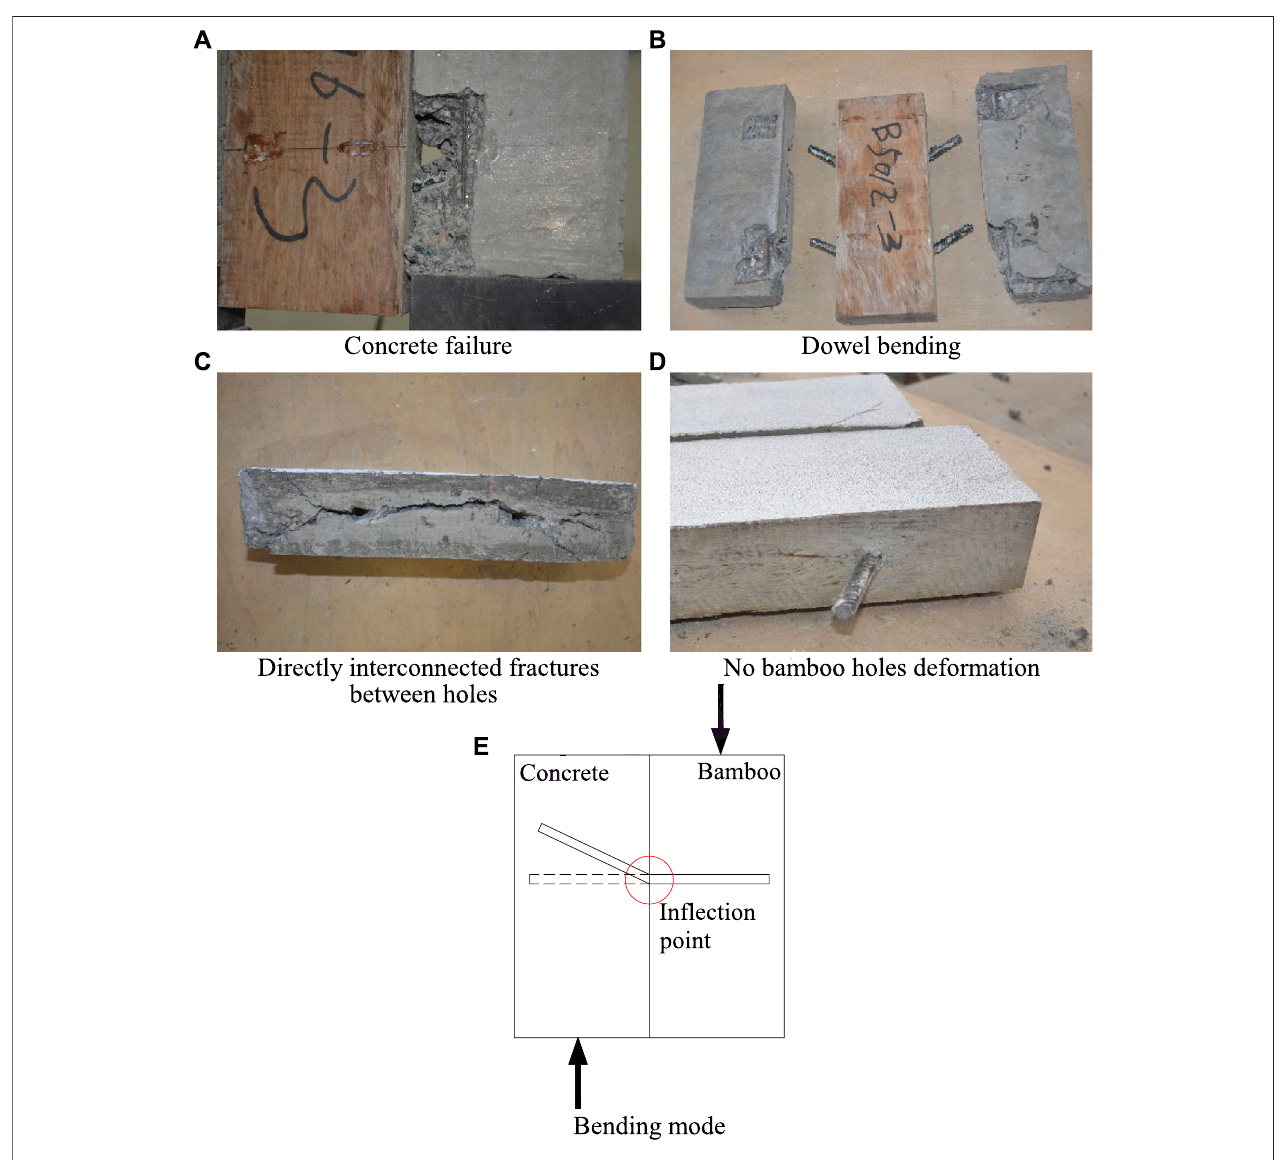
FIGURE 8 | Typical failure mode of bamboo-concrete connection. (A) Concrete failure. (B) Dowel bending. (C) Directly interconnected fractures between holes. (D) No bamboo holes deformation. (E) Bending mode.